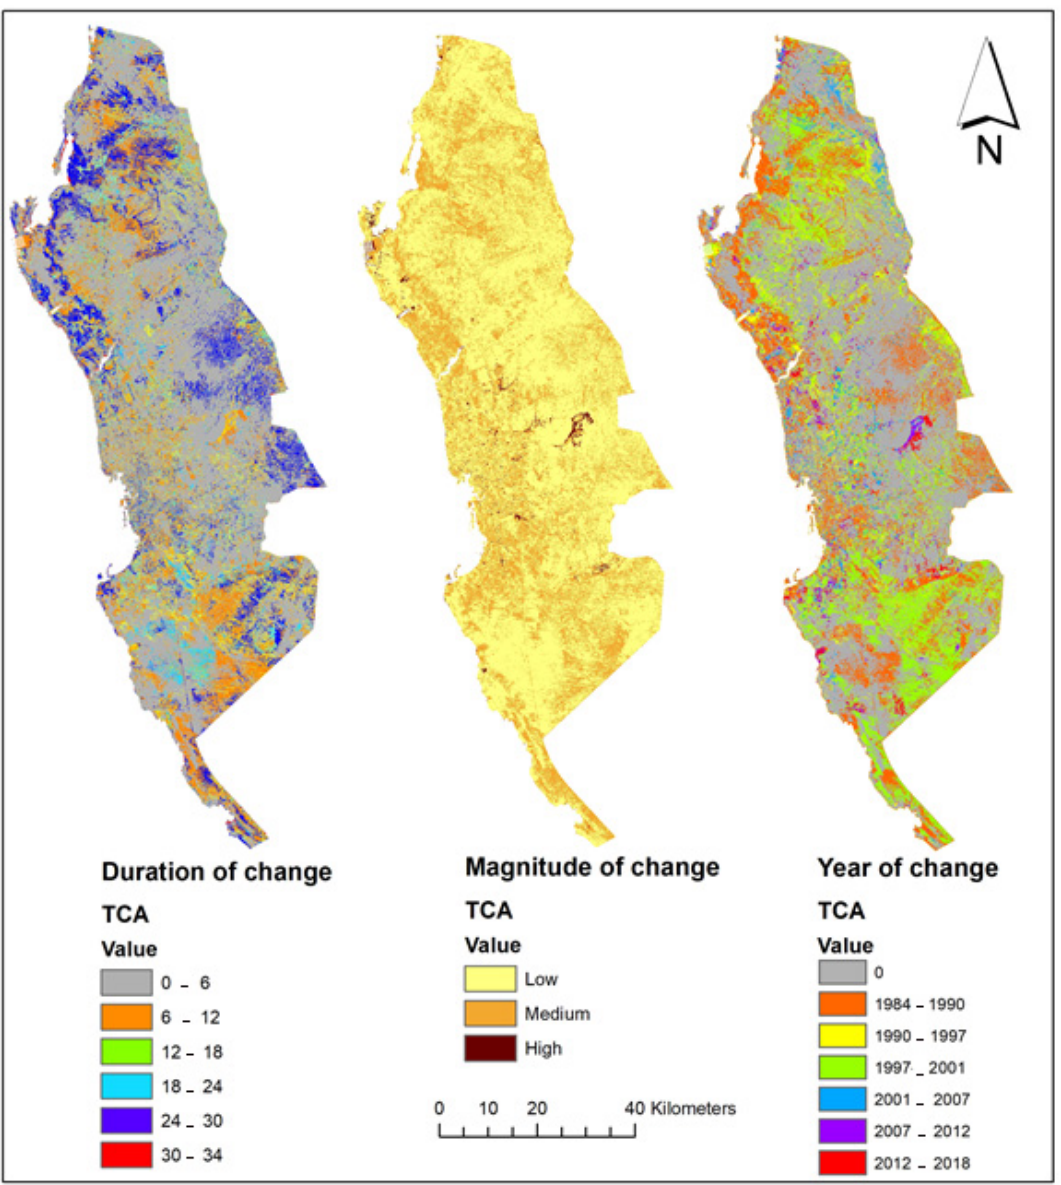
Figure 5. Example of TCA results in the case study. The image on the left represents the duration of the change within the 34 years. The image in the middle represents the magnitude of the change. The image on the right represents the year of the change.